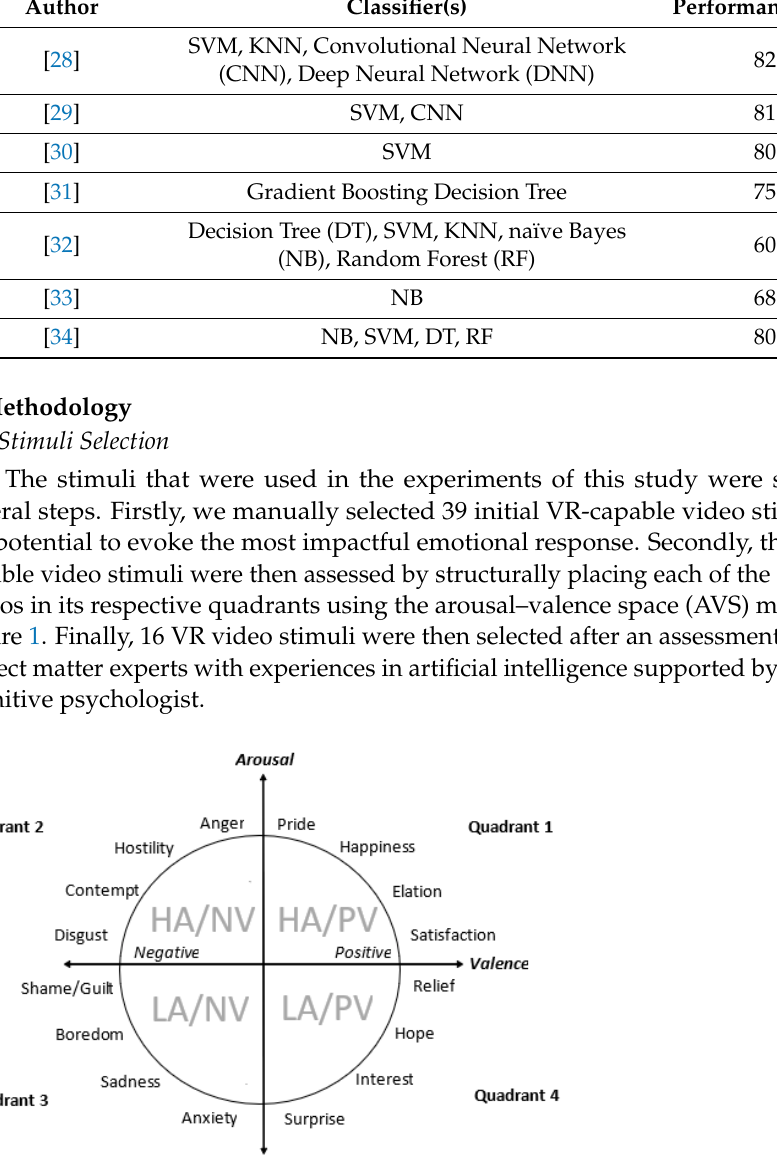
Figure 1. Arousal–valence Space (AVS)